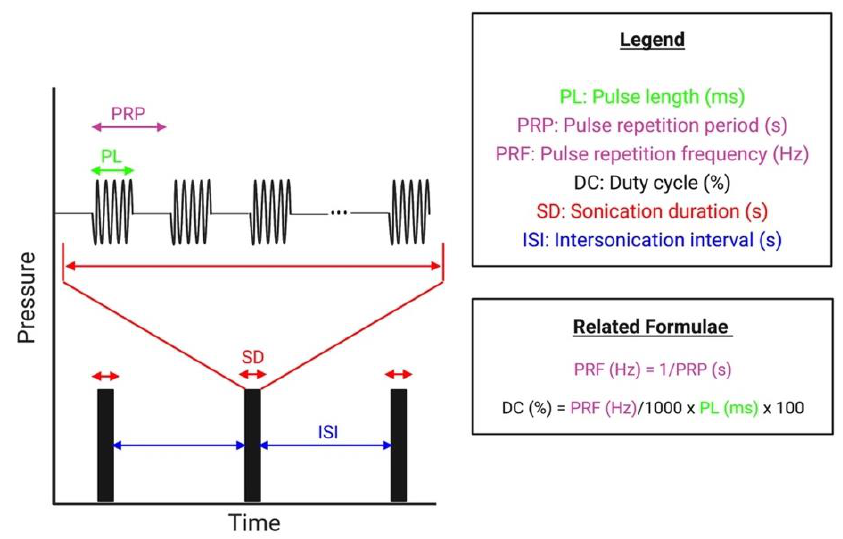
Figure 5. Overview of the pulsed delivery paradigm used for US delivery. ( Created with Biorender.com (accessed on 12 March